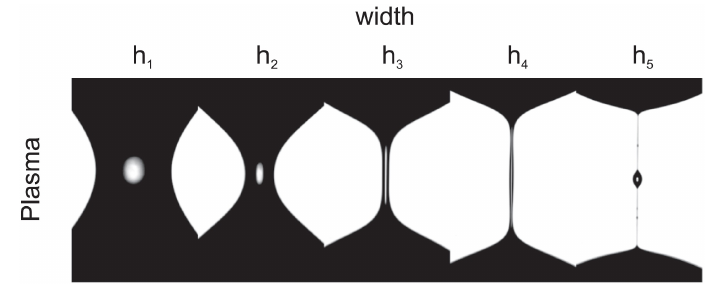
Figure 10. Images of the capillary break extensional experiment